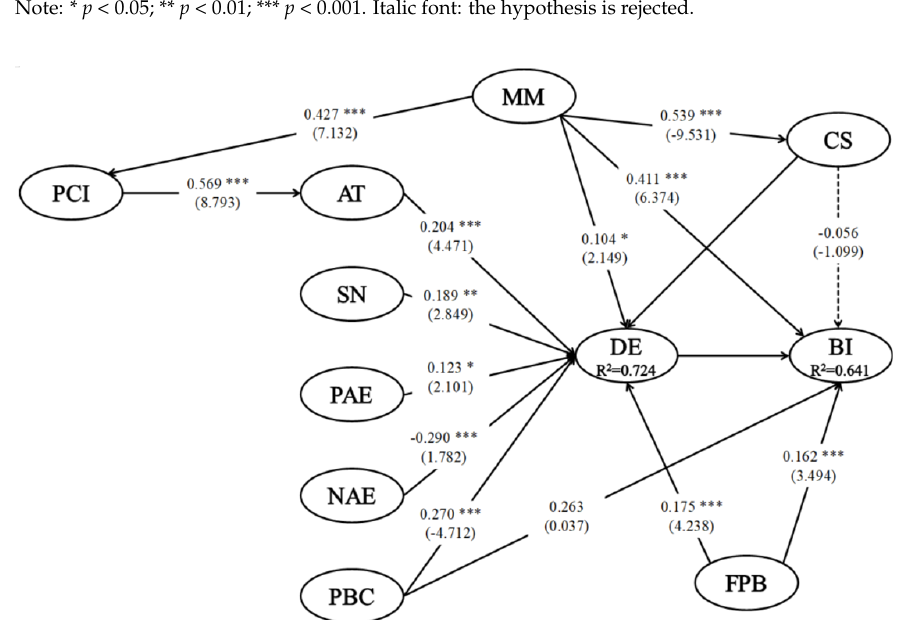
Figure 4. Structural model results. Note: * p < 0.05; ** p < 0.01; *** p < 0.001. Note 2: AT = attitude; SN = subjective norm; PAE = positive anticipated emotion; NAE = negative anticipated emotion; PBC = perceived behavioural control; PCI = perceptions of country image; MM = mass media; DE = desire; BI = behavioural intention; CS = concerns; FPB = frequency of past